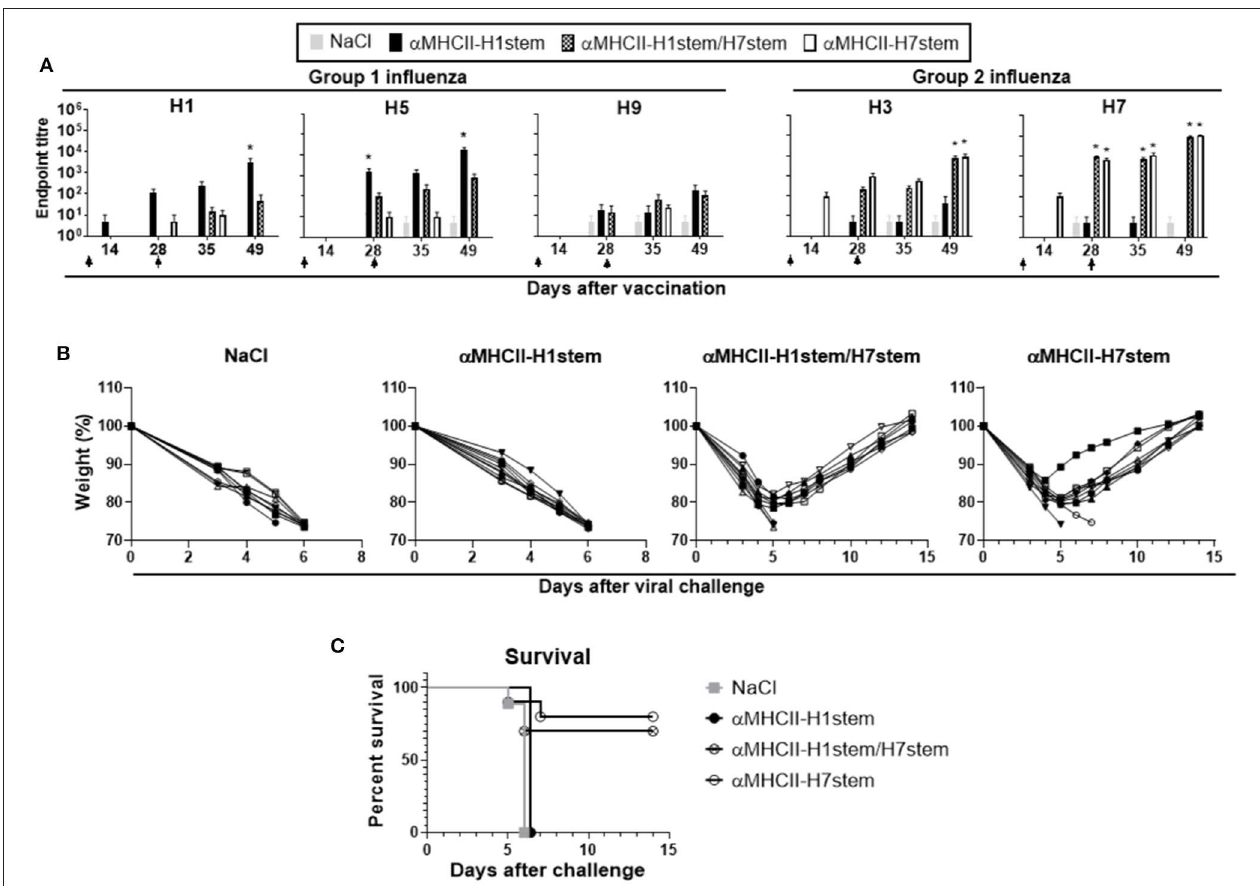
FIGURE 4 | Vaccination and protection against challenge with H7N1 influenza. (A) BALB/c mice ( n = 10 mice/group) were immunized on days 0 and 28, as indicated by arrows, and sera analyzed for development of IgG responses against recombinant HA from PR8 (H1N1), A/Hong Kong/1/1968 (H3N2), A/Hong Kong/483/97 (H5N1), A/Shanghai/1/2013 (H7N9), and A/Hong Kong/1073/99 (H9N2). Values given are mean ± SEM. * p < 0.05 as compared to NaCl (two-way ANOVA and Bonferroni post-test). (B) At day 49 after vaccination, mice were challenged with 5 × LD50 of influenza A/turkey/Italy/3889/1999 (H7N1) and monitored for weight (B) and survival (C)